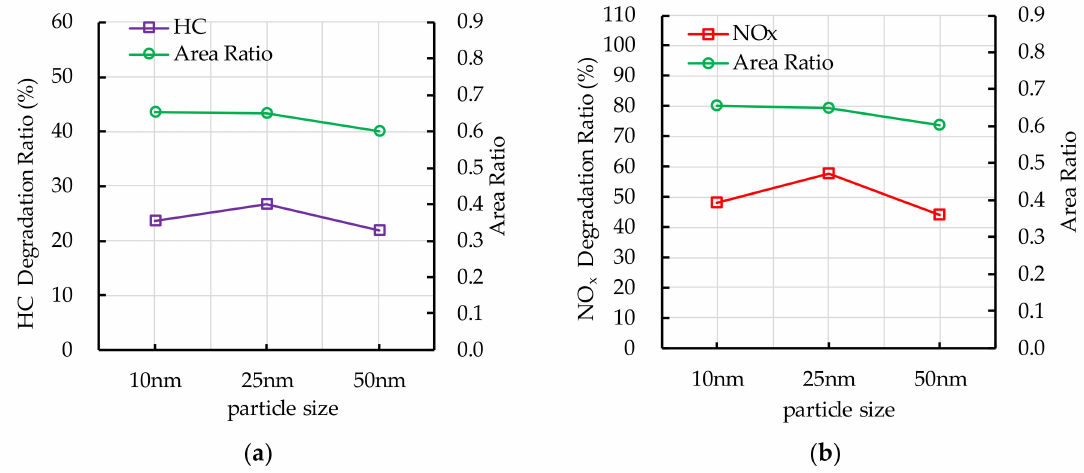
Figure 18. E ff ect of TiO 2 particle size on photocatalytic degradation and area ratio: ( a ) HC; ( b ) NO x .